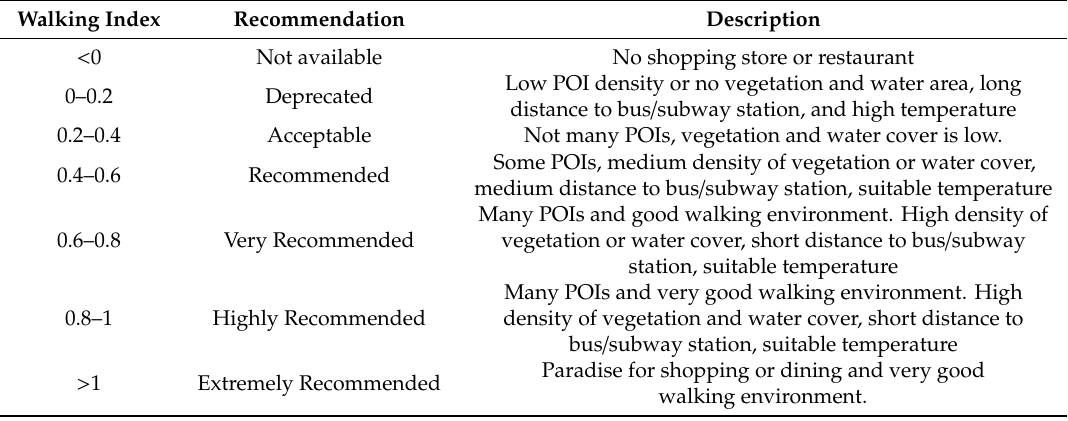
Table 3. Walking index ranges and levels of